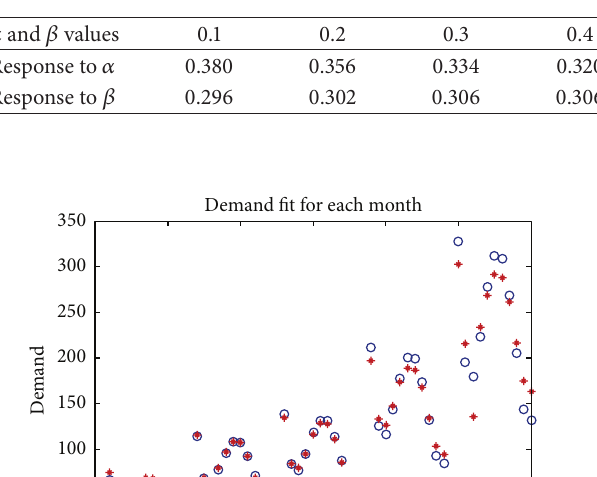
Table 7: Average of lost sale percentage for different values of 𝛼 and 𝛽 .